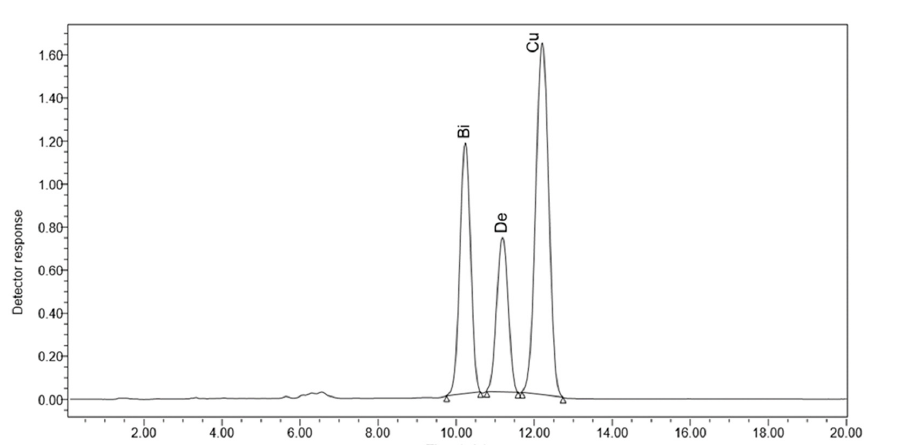
Figure 1. HPLC chromatogram of organic extract of C. longa exposed to 40 mgL − 1 ZnO NPs. The peaks for the different curcuminoid compounds [bisdemethoxycurcumin (Bi), dimethoxycurcumin (De), and curcumin (Cu) were shown.